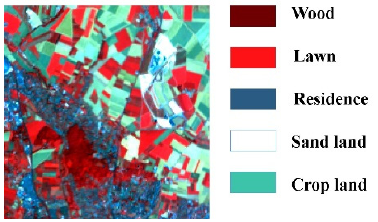
Figure 12. False color composite of the Hyperion sub-scene and five selected landscapes.